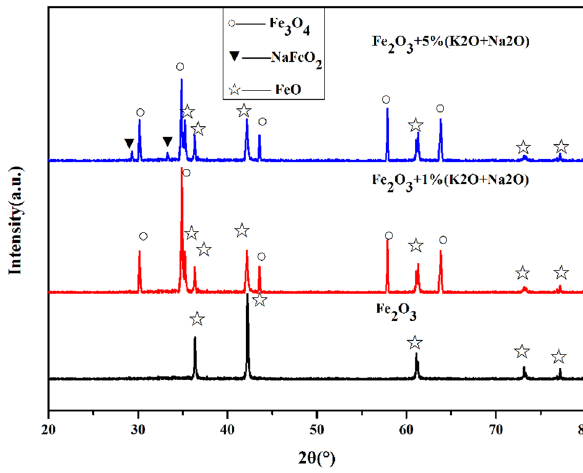
Figure 12: XRD analysis of reduced briquettes with vary ( K 2 O + Na 2 O ) at the second stage.